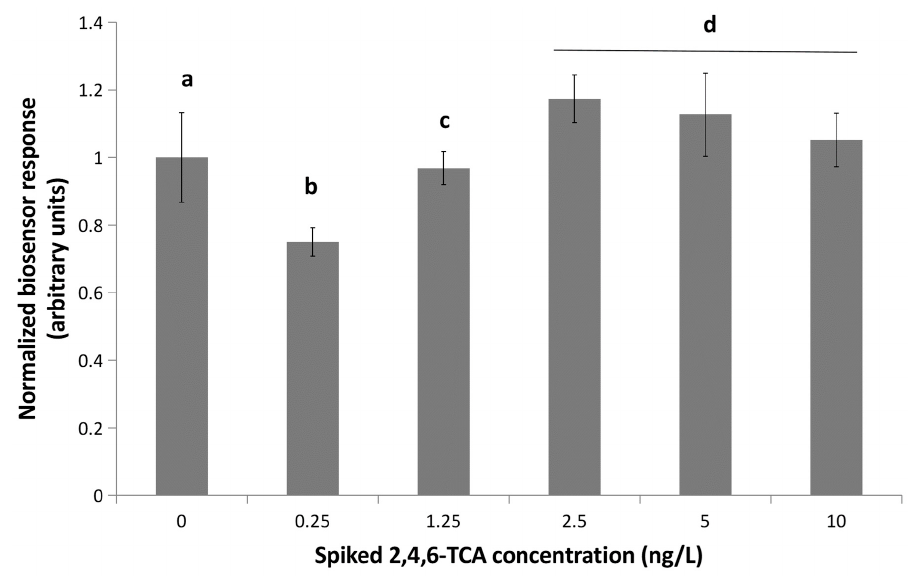
Figure 5. The average normalized biosensor responses against the different spiked 2,4,6-TCA concentrations using cellular biorecognition elements membrane-engineered with 0.3 ng/mL anti-TCA antibody ( n = 24 replications for each concentration, and error bars represent the standard errors of the average value of all replications with each range of concentration). Different letters (a, b, c, d) indicate statistically significant different values ( p < 0.01).